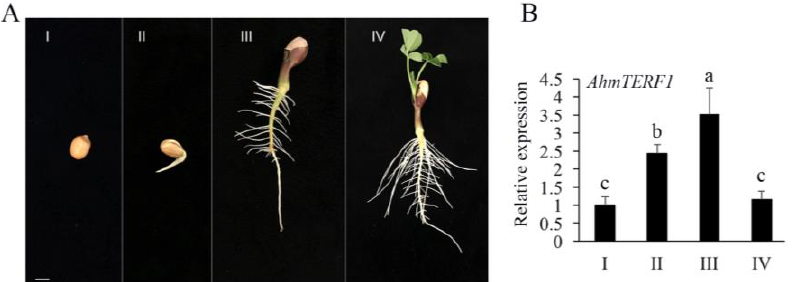
Figure 3. Expression pattern of AhmTERF1 at various peanut root growth stages. ( A ): Phenotype at various peanut root growth stages. Scale bar: 1 cm. ( B ): AhmTERF1 expression level at the corresponding root growth stages. Lower case letters (a, b, c) indicate significantly different groups ( p < 0.05).